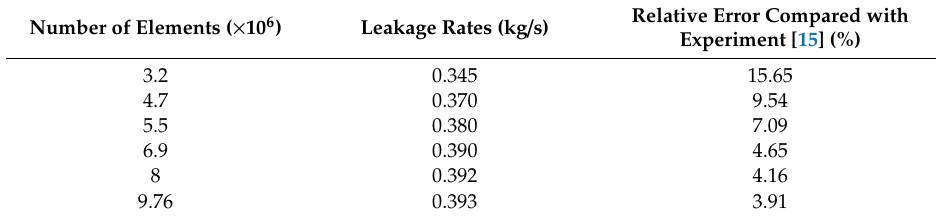
Figure 4. Computational model and meshing of constant clearance damper seals. Table 2. Influence of the number of grid elements on leakage rates.